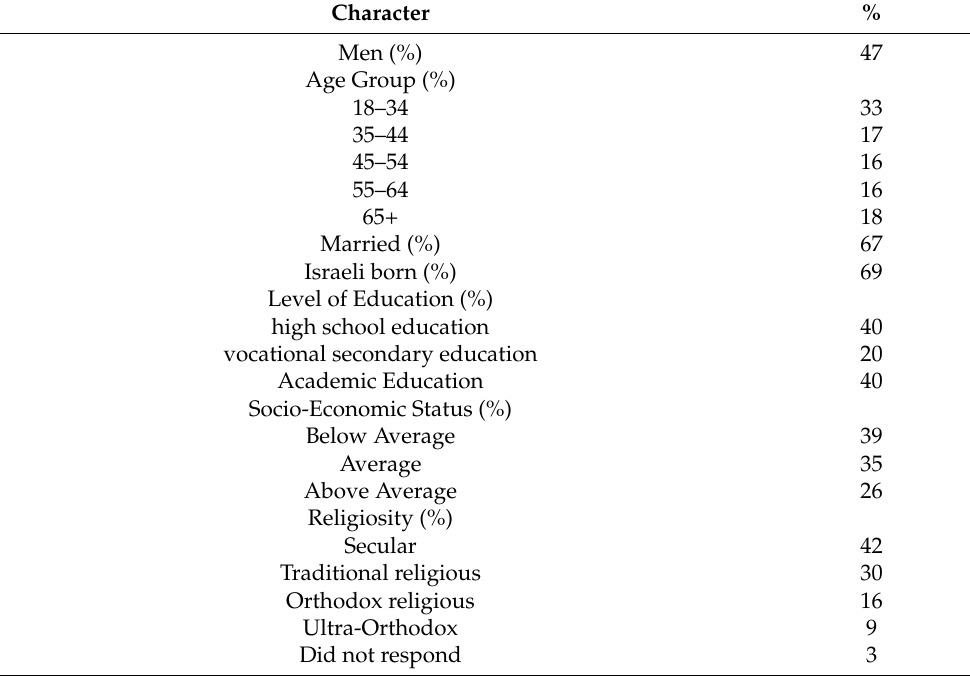
Table 2. Public Respondents’